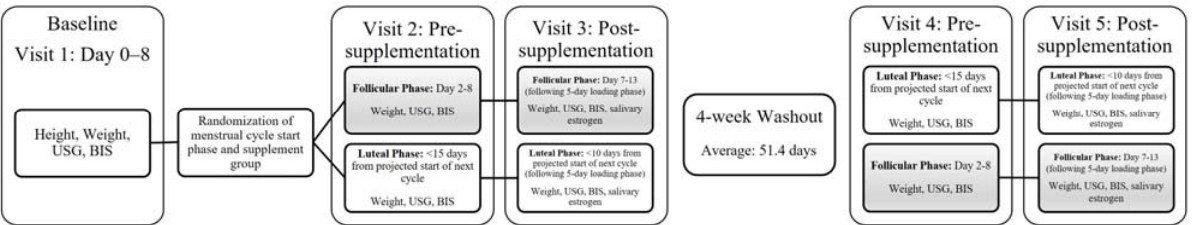
Figure 2. Experimental design [Urine Specific Gravity (USG), Bioelectrical Impedance Spectroscopy (BIS)]. Note: Subjects were randomized to supplement group (PL or Cr) and hormonal phase order, with a minimum 4-week washout period to ensure testing across multiple cycles and account for familiarization.